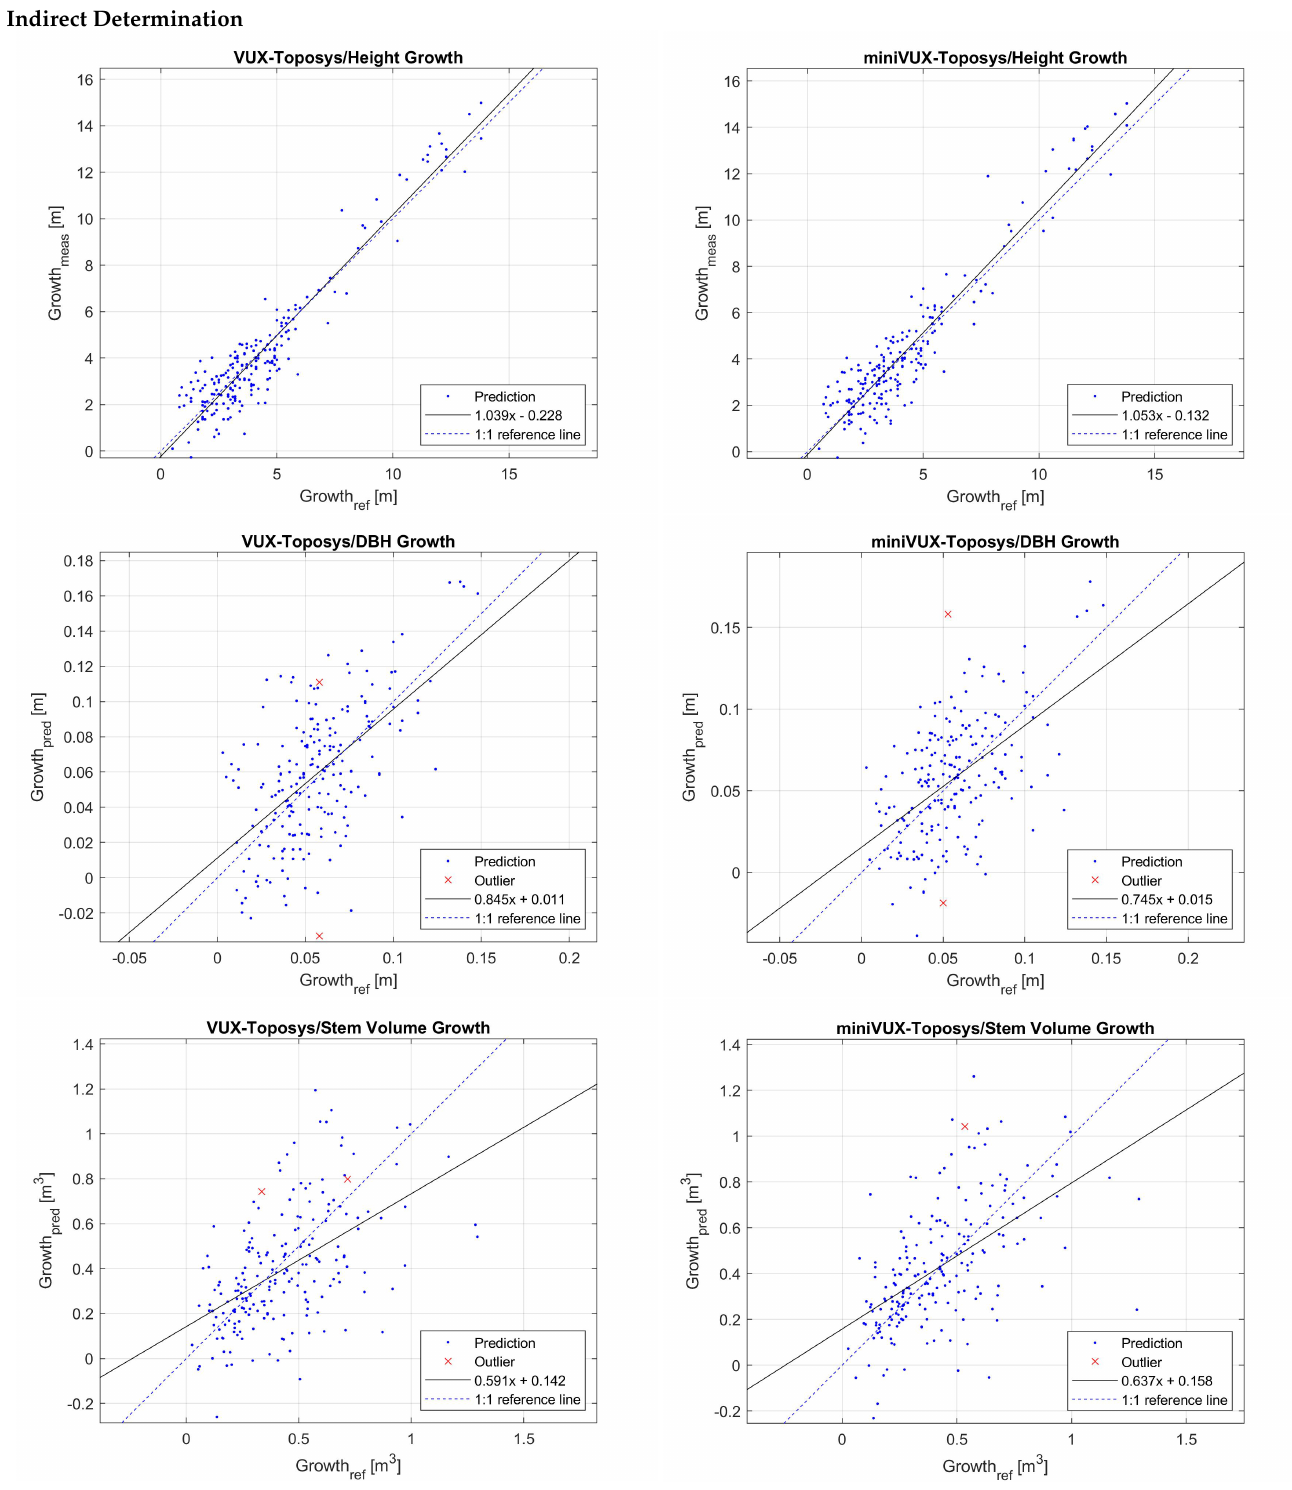
Figure 7. The accuracy of the indirect growth determination. Note that the height growth measure- ment is the most accurate, because determining the value is a direct measurement. Other values involve a prediction of the growth value, which degrades the quality of growth